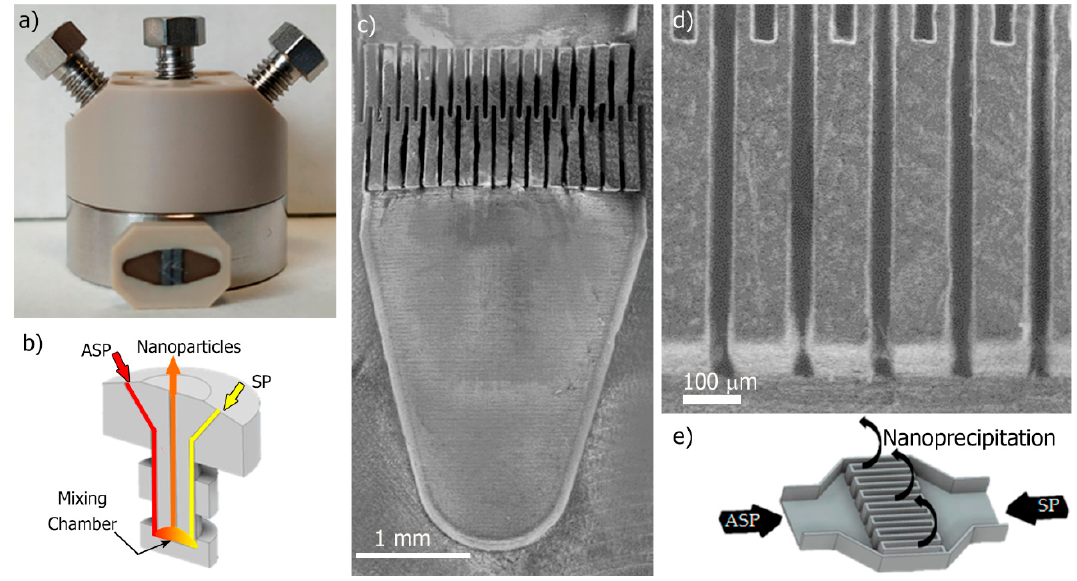
Figure 3. ( a ) Optical image of the interdigital multilamination micromixer, housing and mixing unit; ( b ) Scheme of the ASP and SP inlet stream distribution and the resulting nanoprecipitated stream; ( c , d ) Scanning Electron Microscopy images of the inner microstructure of the micromixer unit; ( e ) Scheme to show that the multilamination promotes mixing by diffusion-driven mass transfer. Table 2. Parameters and conditions used for the Eudragit ® RS100 nanoparticle synthesis by microfluidic